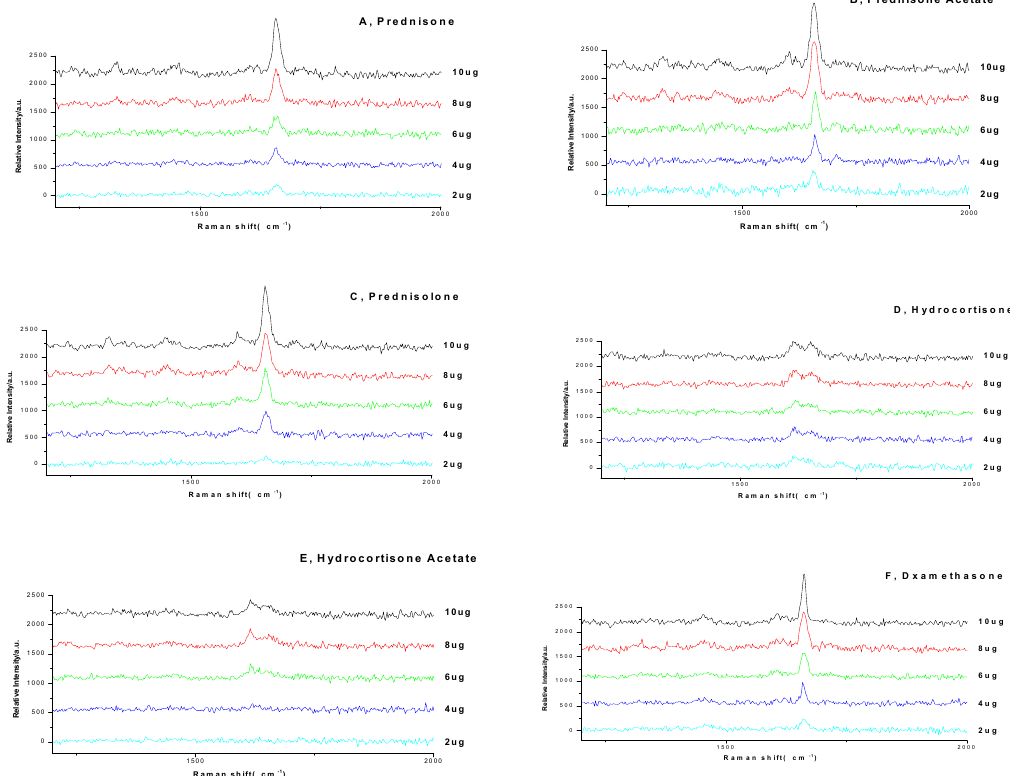
Figure 7. The Raman spectra of different deposition amount of reference substances on TLC.